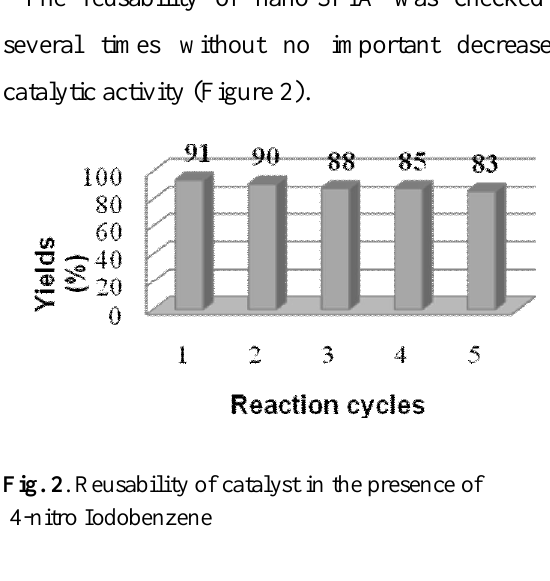
Table 3. The stability study of some aryl diazonium nano silica periodate at room temperature a Diazonium salt Prduct